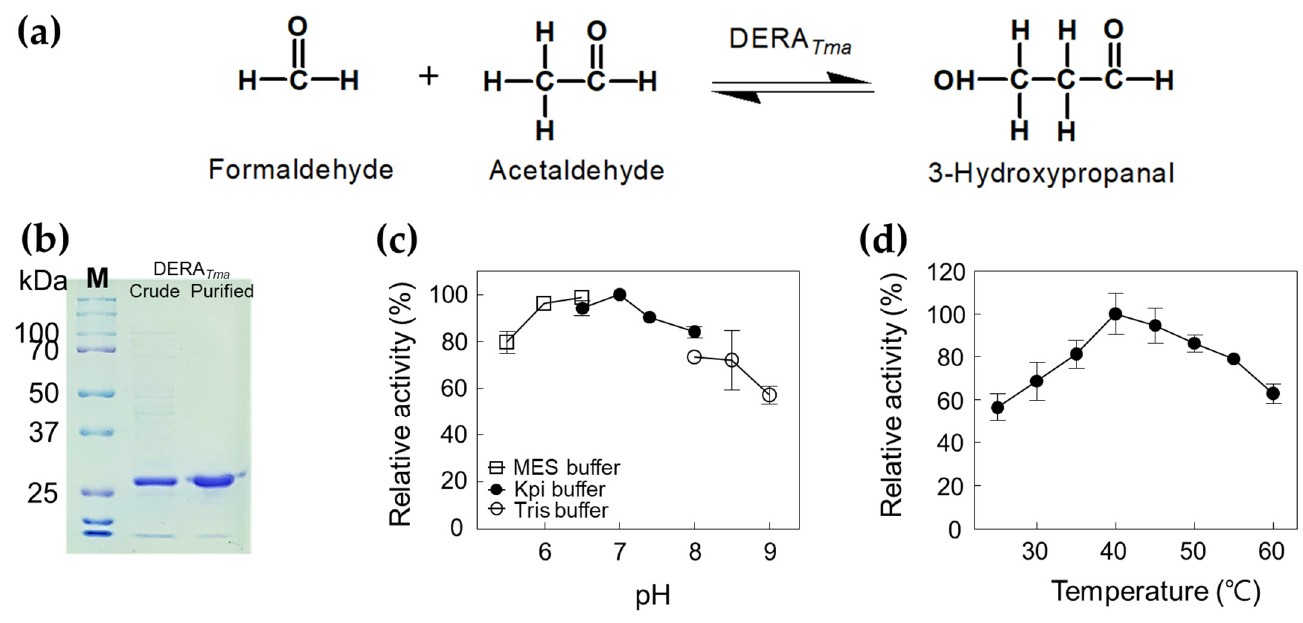
Figure 2. Characterization of DERA Tma for 3-HPA production from formaldehyde and acetaldehyde. ( a ) Scheme of 3-HPA production from formaldehyde and acetaldehyde by DERA Tma . ( b ) SDS-PAGE analysis of DERA Tma . All protein bands were stained using Coomassie blue. Molecular mass markers (M) indicate 250, 150, 100, 70, 50, 37, and 25 kDa. ( c ) Effect of pH on DERA Tma activity. The reactions were performed in 20 mM MES buffer (pH 5.5–6.5), 20 mM Kpi buffer (pH 6.5–8.0), and Tris buffer (pH 8.0–9.0) with 0.5 mg/mL enzyme, 20 mM formaldehyde, and 20 mM acetaldehyde at 30 °C for 10 min. ( d ) Effect of temperature on DERA Tma activity. The reactions were performed in 20 mM Kpi buffer (pH 7.0) with 0.5 mg/mL enzyme, 20 mM formaldehyde, and 20 mM acetaldehyde at different temperatures for 10 min. Data represent the means of two separate experiments, and error bars represent the standard deviation.